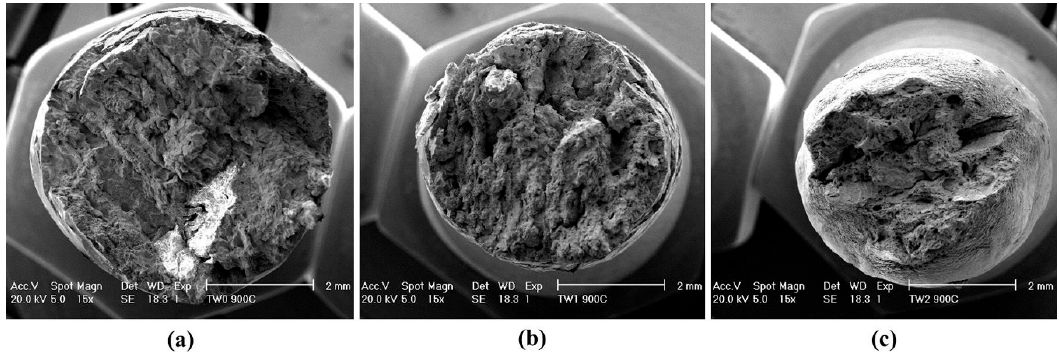
Figure 13. Fracture surface appearance of hot-tensile-tested TWIP steels showing a remaining solidification structure component after testing at 900 °C: ( a ) TW-B0, ( b ) TW-B1 and ( c ) TW-B2.